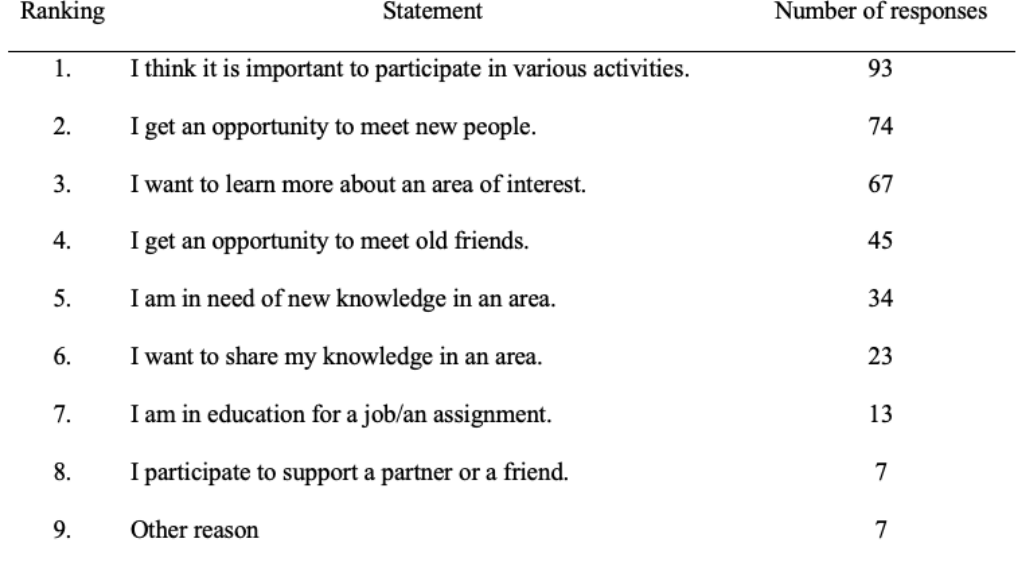
Table 1. Arguments why the respondents participate in formal and